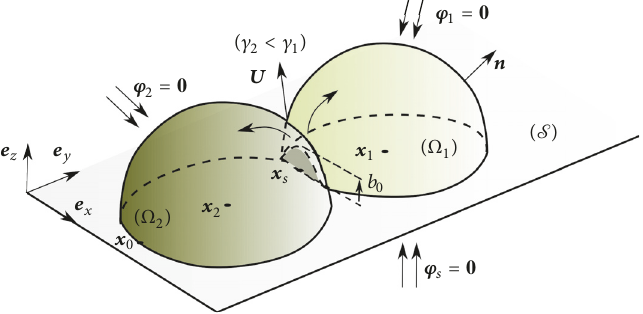
Figure 1: A freehanded illustration of the coalescence of two liquid droplets.